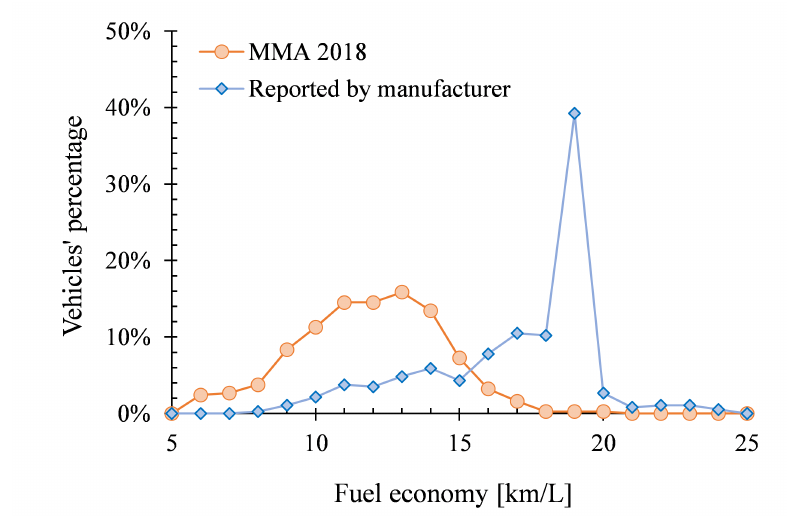
Figure 8. Comparison between the fuel economy reported by manufacturers and the real values obtained from circulating vehicles in